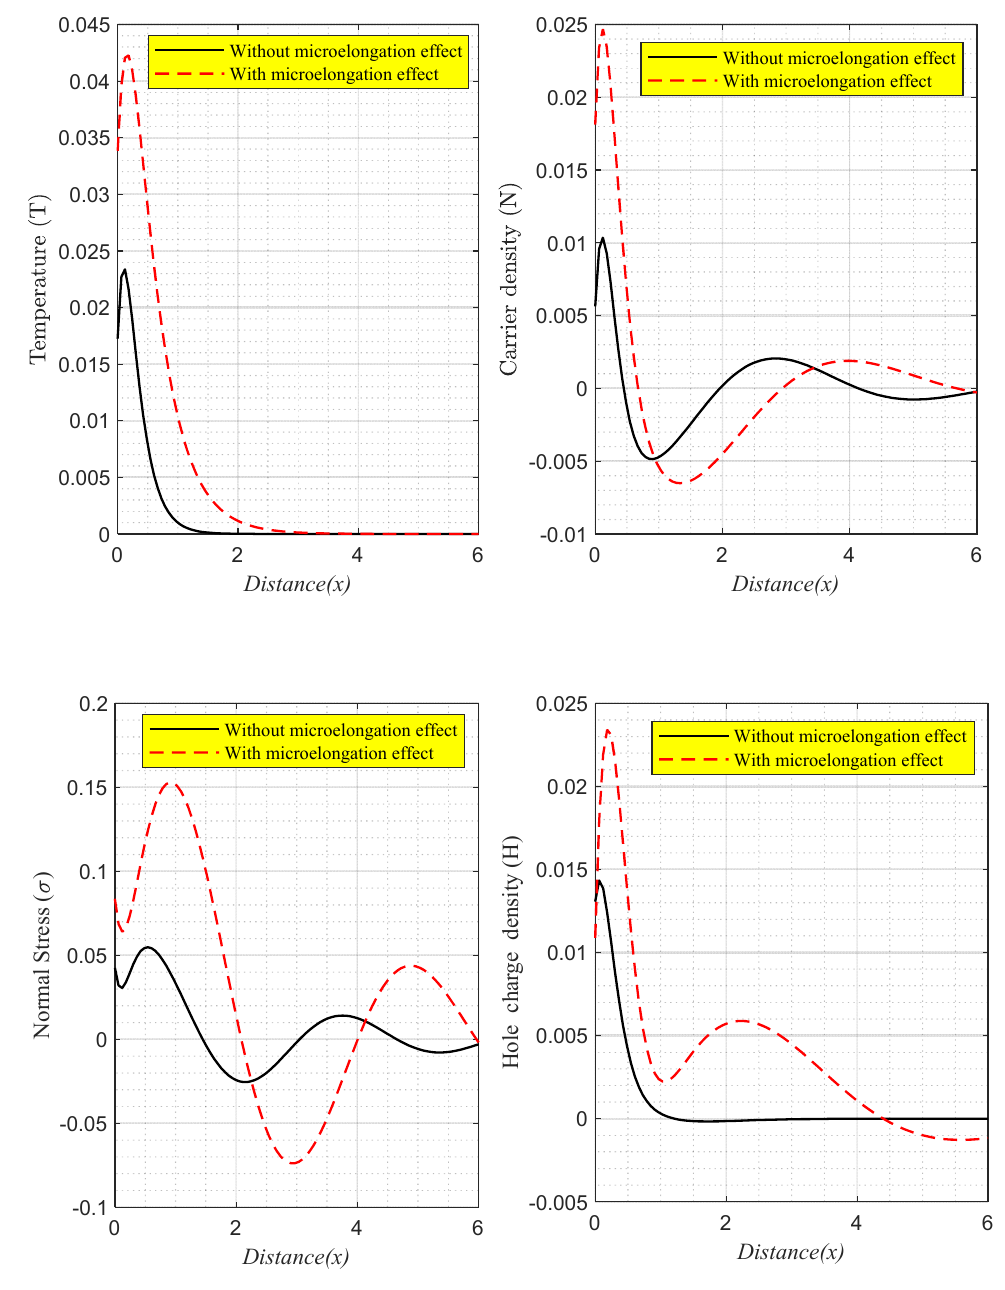
Figure 4. The main field distributions in distinct two temperature cases under the influence of laser pulses vary with horizontal distance in accordance with the DPL model.